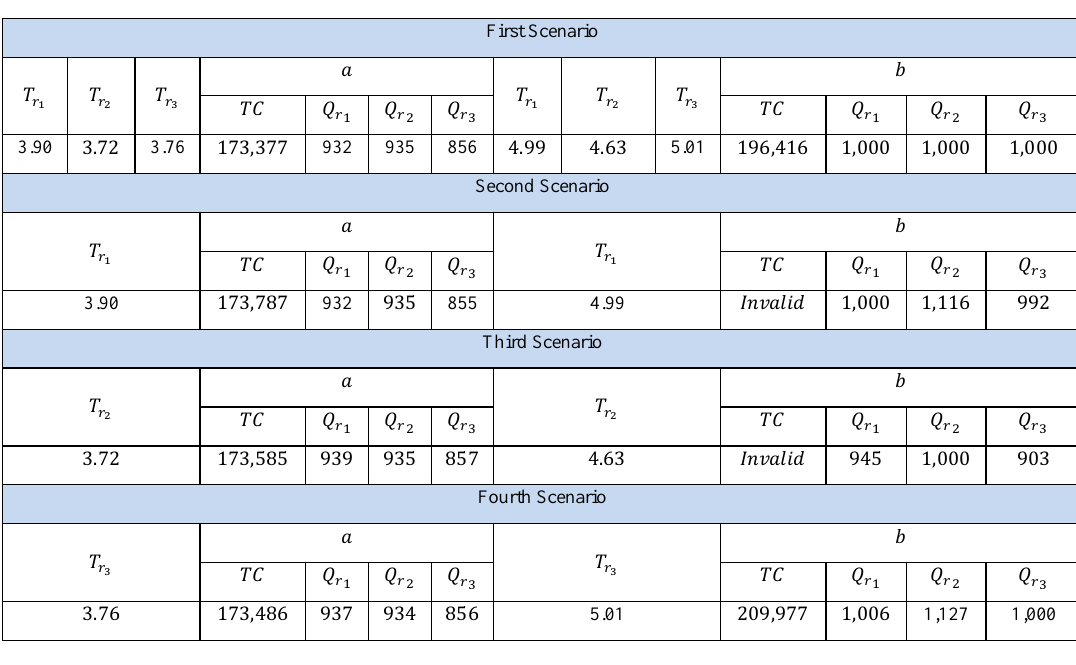
Table 2. Scenarios and optimal